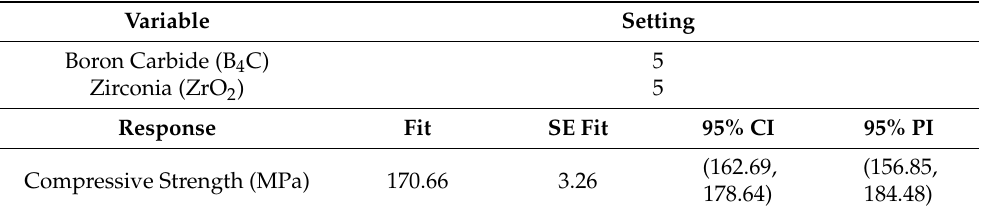
Table 4. Optimisation values over compressive-strength